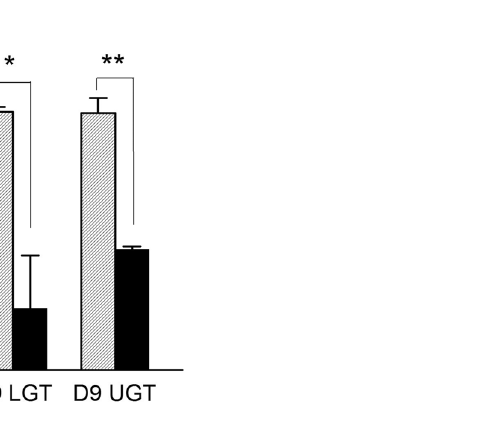
Fig. 6. Quantitative PCR Assessment of Bacterial Genomic Burdens in Lower and Upper Genital Tracts from C. caviae Mock or (PBS) Vaccinated Guinea Pigs. Groups of three animals were euthanized on days 3 and 9 after C. caviae i.vag. challenge and tissues representing the lower or upper genital tract were aseptically collected. DNA was subjected to qPCR for GAPDH (host target used for normalization) and the single copy C. caviae tryptophan synthase gene (quantification of bacterial load). The average bacterial burdens for each tissue are depicted as grey (mock-vaccinated) or black (vaccinated) bars for each tissue and time point. LGT: lower genital tract. UGT: upper genital tract. * p , 0.05, ** p , 0.01.